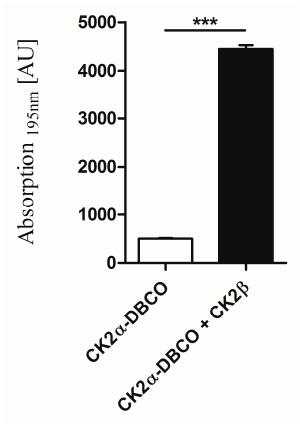
Figure 6. Proof of interaction between CK2 β and the CK2 α -DBCO-subunit. The activity of CK2 α -DBCO545 [ □ ] alone and by addition of purified CK2 β [ ■ ] was analyzed by CE assay. There were significant differences in activity ( n = 3, error bars ± SEM, *** p < 0.0001, unpaired t test).